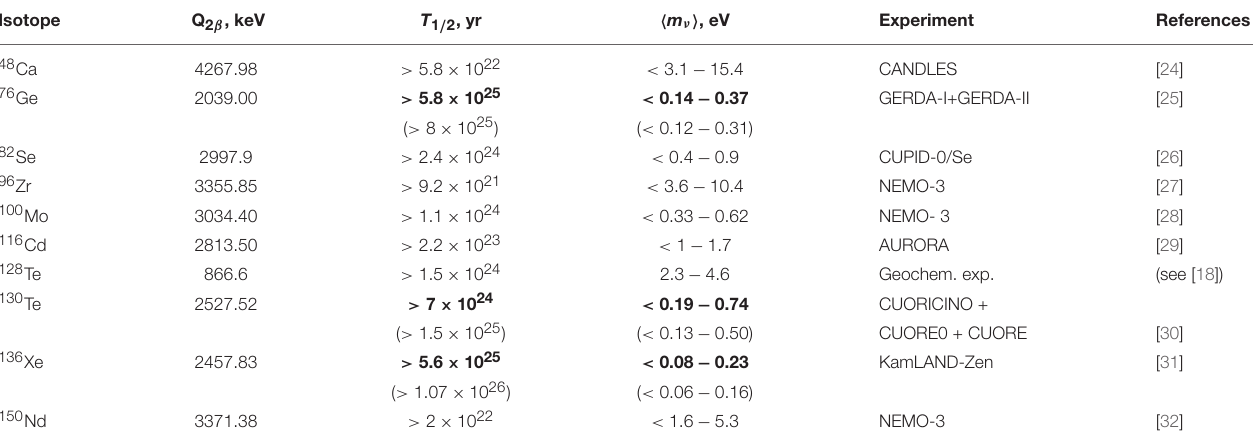
TABLE 1 | Best present limits on 0 νββ decay (at 90%